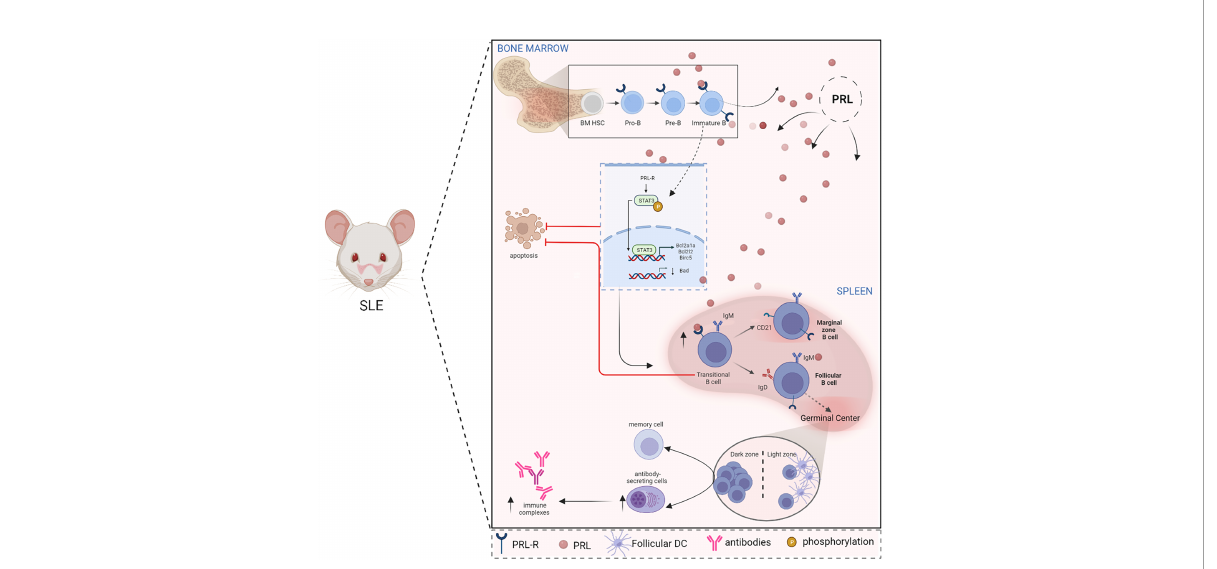
FIGURE 2 PRL alters B cell ontogeny in SLE. In SLE, there is a relationship between PRL and the ontogeny of B cells since the PRL receptor is present in the different stages of maturation of these cells in the bone marrow (Pro-B, Pre-B, and immature B cells) as in the spleen (transitional cells). PRL signaling in immature and transitional cells in fl uences the evasion of clonal elimination mechanisms (apoptosis), promoting the development of autoreactive B cells. In immature cells, PRL favors STAT3 signaling and increases the expression of anti-apoptotic genes, such as BCL2A1A, BCL2L2 , and BIRC5 , while pro-apoptotic genes, such as BAD , are downregulated. The development and survival of autoreactive B cells correlate with the formation of autoantibody-producing cells and the consequent formation of immune complexes that increase the clinical manifestations of SLE (Created with